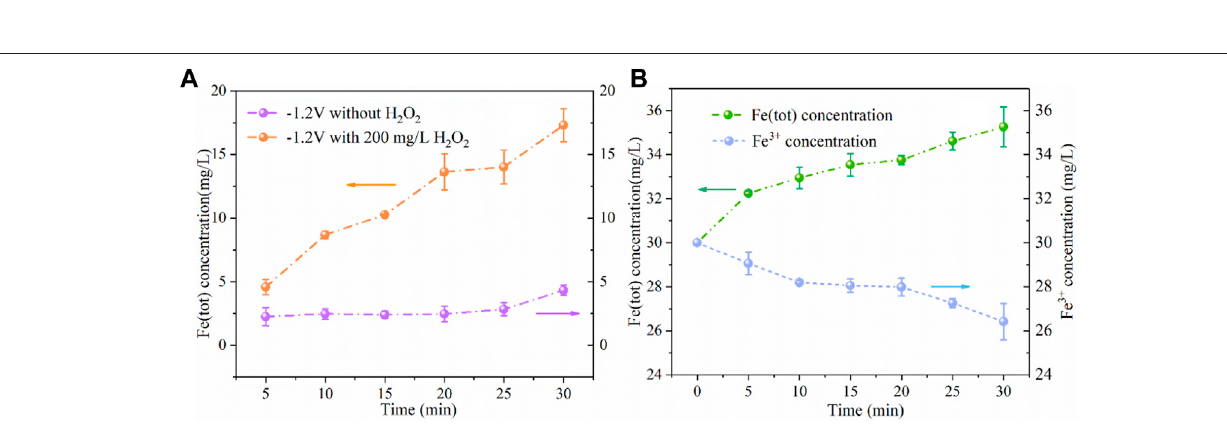
FIGURE 9 | Concentration variations of PNP (A) and COD (B) under different conditions (PNP (cid:1) 100 mg/L, Na 2 SO 4 (cid:1) 3 g/L).